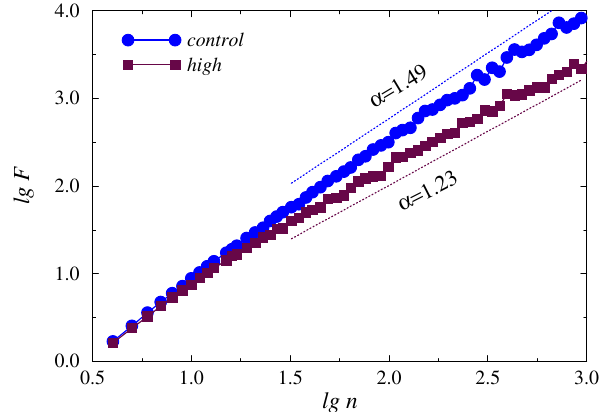
Fig. 4. The dependencies of lg F versus. lg n showing di®erent slopes in the region of long-range correlations between control recordings and recordings related to a late stage of gastric